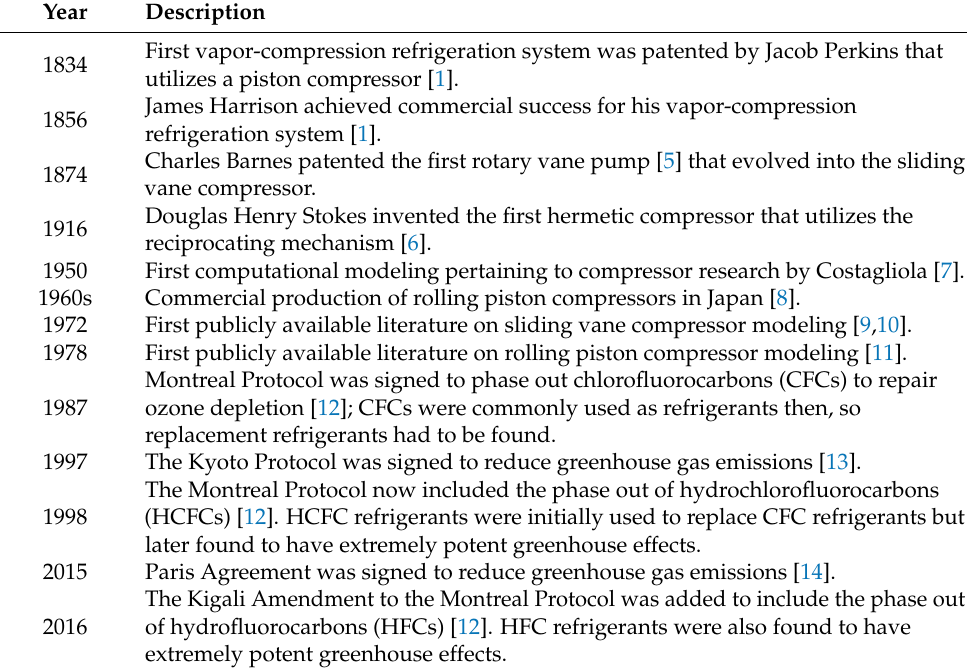
Table 1. Vapor-compression system and rotary compressor